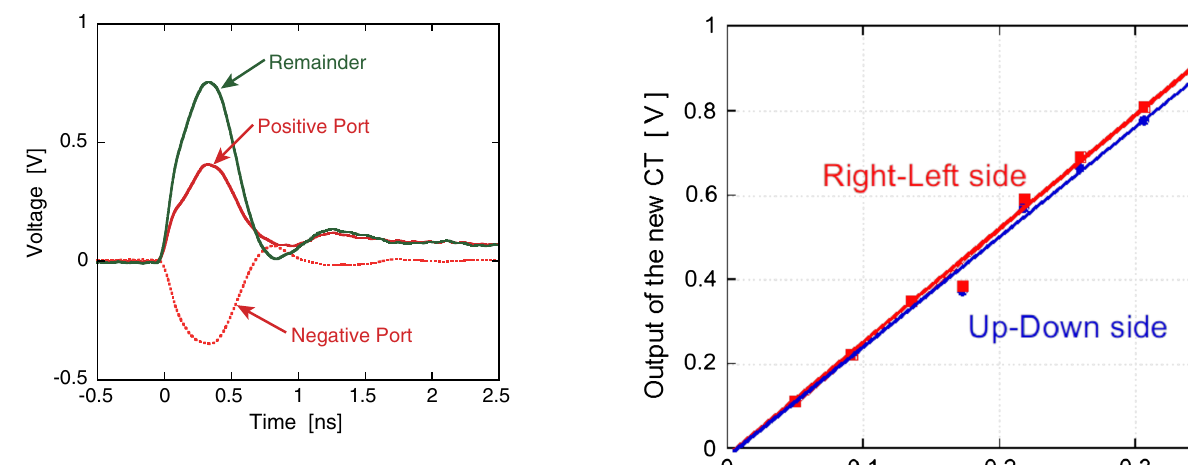
FIG. 13. Typical beam wave forms observed with the DCT in the injector. From up to down, the first (green line) is the subtracting signal between the signals from the positive and negative ports of the DCT in the horizontal. The second (red solid line) is the signal from the positive port and the third (red dotted line) is from the negative port.